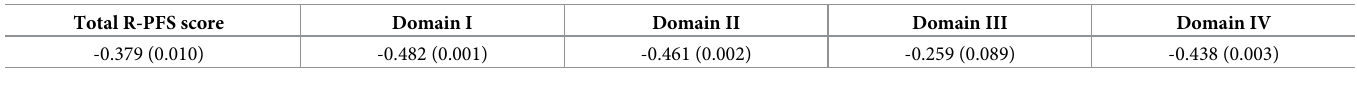
Table 2. Pearson correlation (r,p) between 30-STS test and R-PFS.